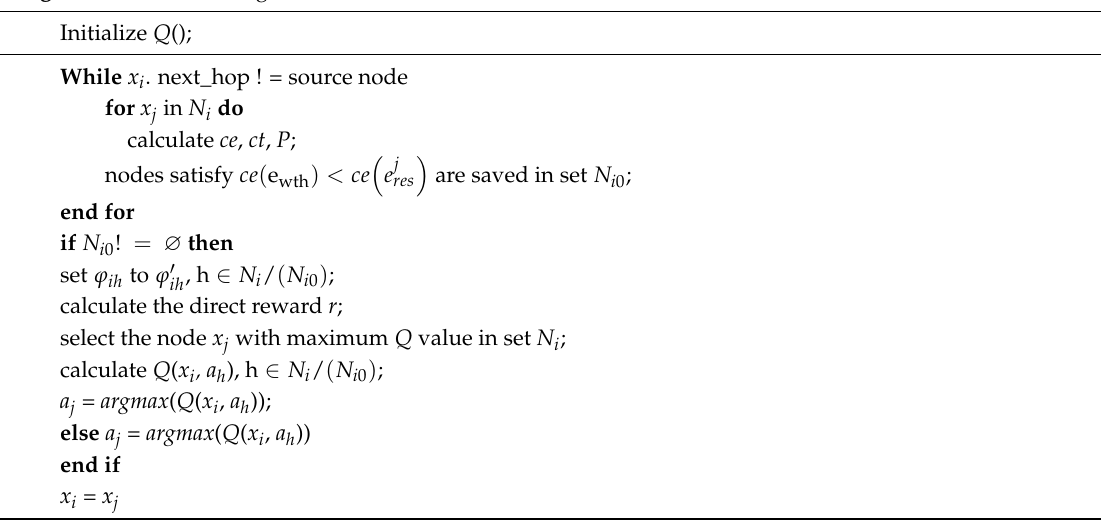
Algorithm 1: The routing